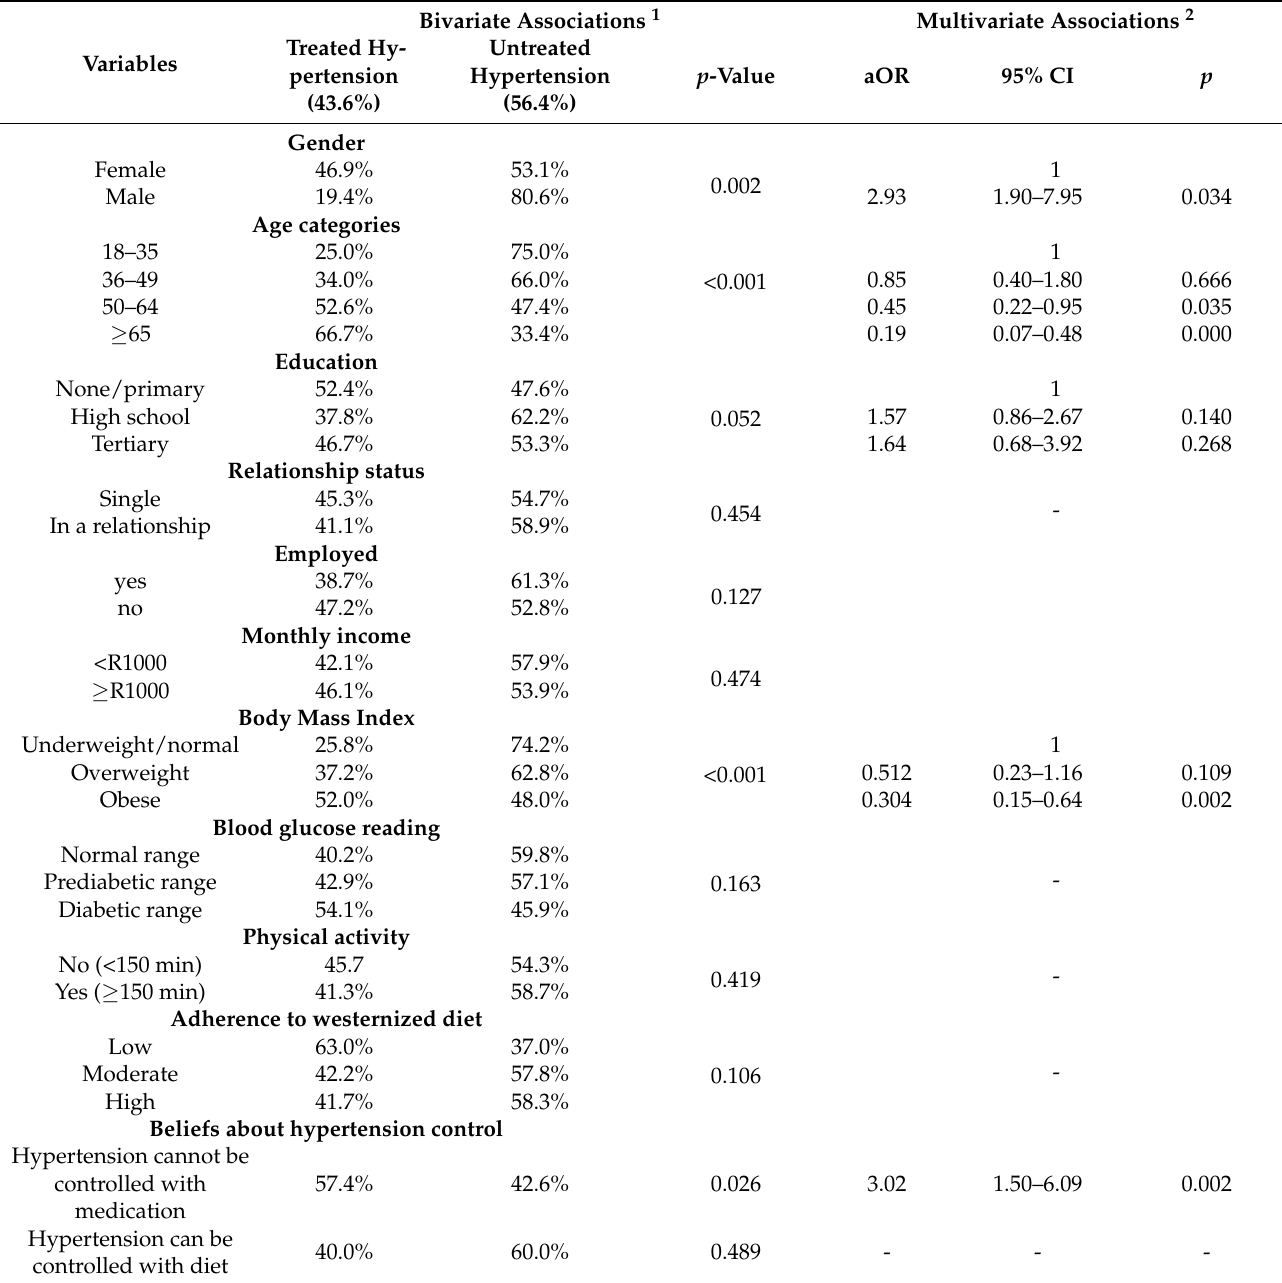
Table 3. Sociodemographic and clinical characteristics associated with untreated hypertension among hypertensive